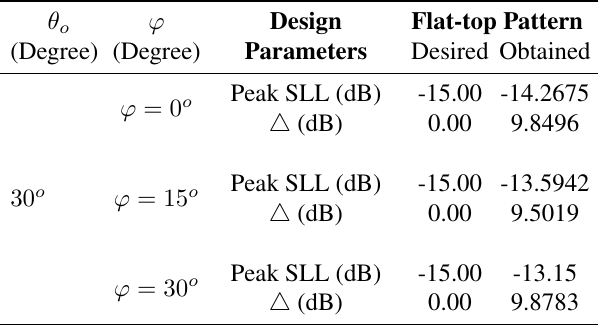
Table 2: Desired and obtained result for scanned Flat-top pattern in predefined ϕ planes